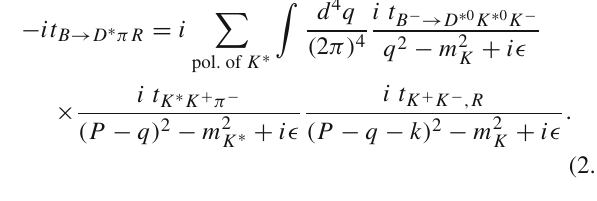
→ ¯ K ∗ 0 B + , ¯ K ∗ 0 → π 0 ¯ K 0 and suggested, where B + c ¯ K 0 B + → π B 0 [35]. Yet, there are large uncertainties quan- s ¯ K 0 B + → π B 0 amplitude and the B + tizing the s weak